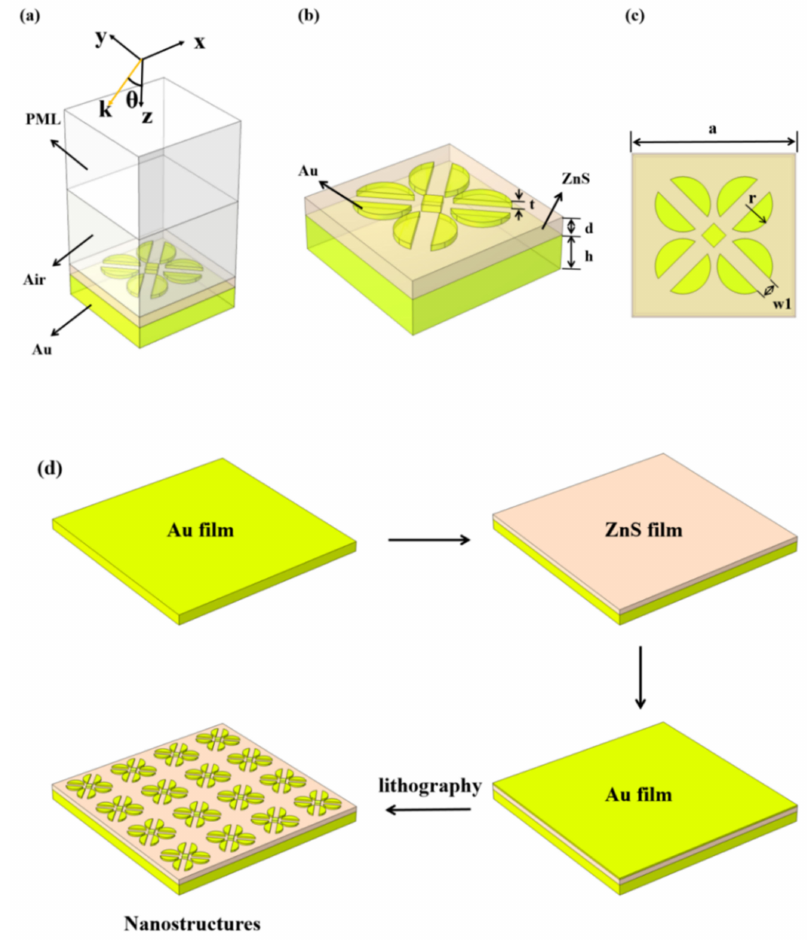
Figure 1. Schematic diagram of the absorber structure: ( a ) a single periodic unit structure, ( b ) front view of the absorber, ( c ) top view of the absorption layer, ( d ) preparation process of the solar absorber